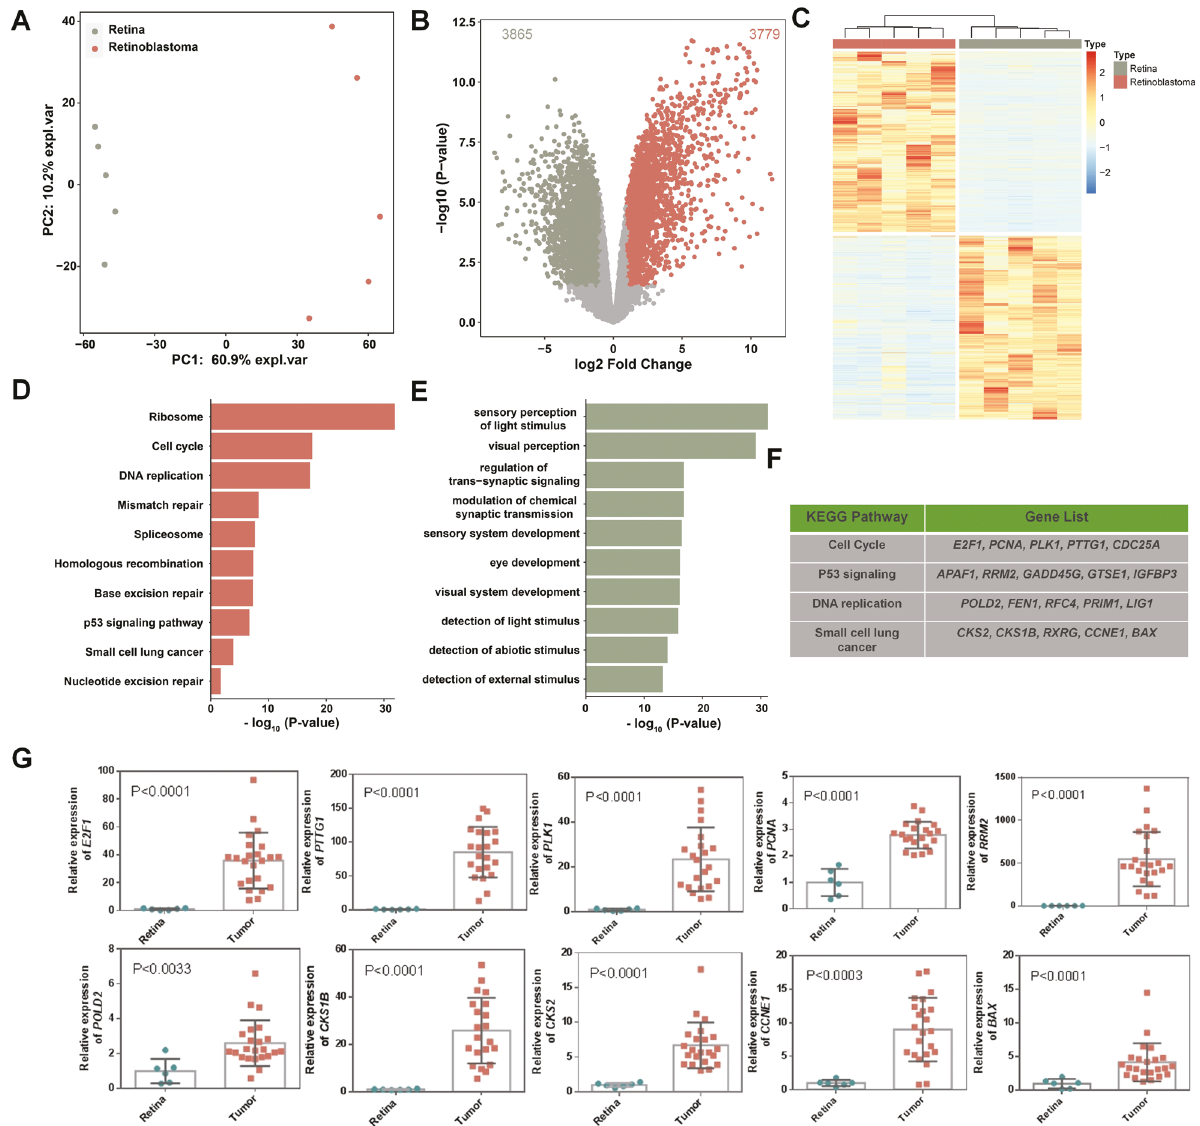
Fig. 1 Global transcriptional dysregulation in retinoblastoma. A Scatter plot depiction of an unsupervised PCA of gene expression level from fi ve RB and fi ve retinal samples. B Volcano plot showing DEGs between RB and normal samples. The red and green dots represent genes with signi fi cantly increased or decreased expression in RB, respectively. C Heatmap of the expression pro fi les for the DEGs between RB and normal samples. Each column represents a sample and each line represents a DEG. D KEGG pathway analysis of the upregulated DEGs. Top annotation clusters are shown according to their enrichment scores [log 10 ( p value)]. Background genes were all stably expressed in these samples. P value was adjusted by Benjamini – Hochberg procedure. E GO analysis for downregulated DEGs. F Representative cancer-related pathways and their corresponding upregulated genes. G Ten cancer-associated genes were validated by qRT-PCR using clinical samples. Each dot represents a sample. *** P < 0.001; ** P < 0.01; * P < 0.05, by two-tailed t